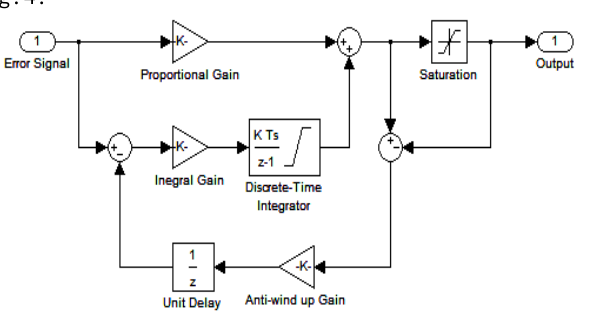
Fig. 6. Bode plot of the open-loop transfer function of the inner current control loop.